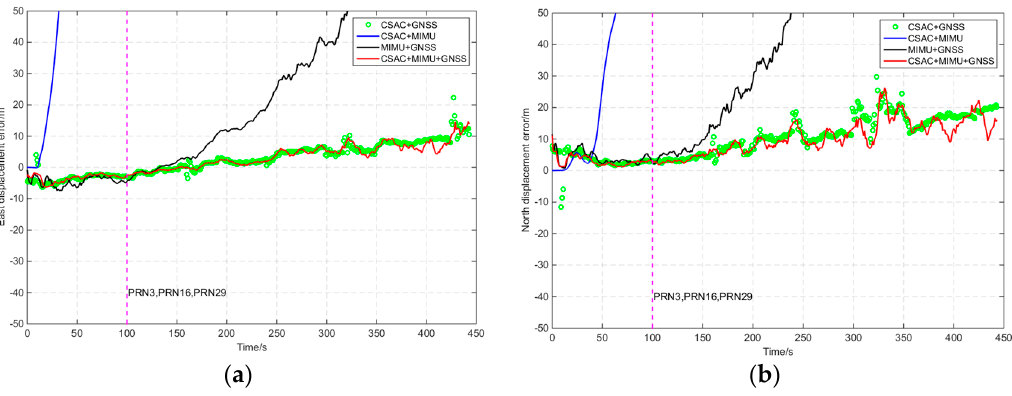
Figure 11. Navigation result comparison of the open-sky route by software mask. ( a ) East displacement error with time; ( b ) North displacement error with time. Table 6. Navigation result comparison of the open-sky route by software mask.